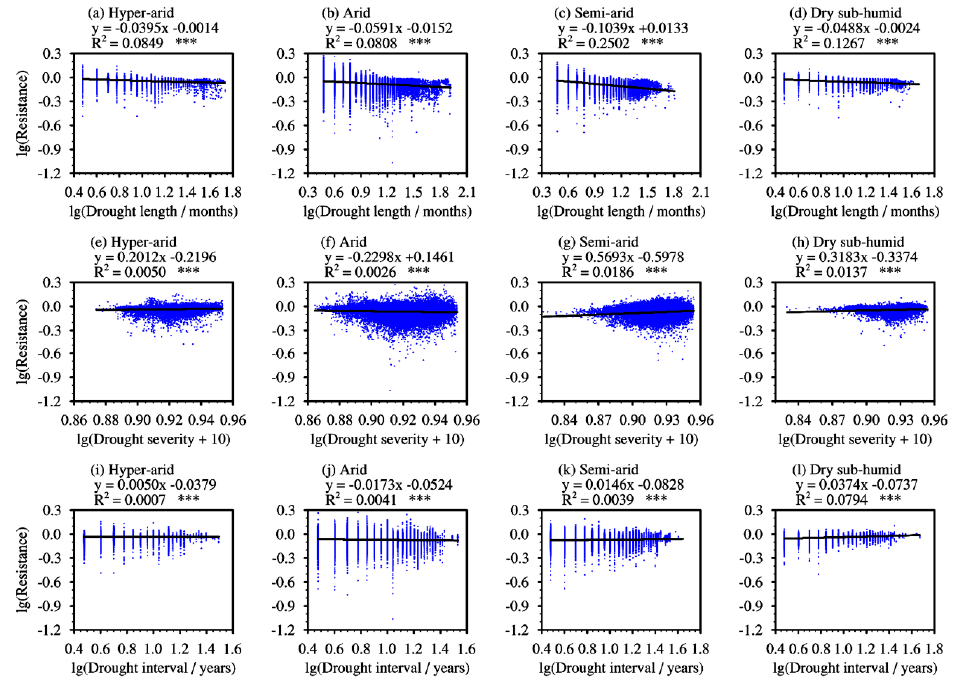
Figure 5. Changes in resistance as drought intensity in ( a – d ) drought length, ( e – h ) severity, and ( i – l ) interval increases in case of incomplete resistance (resistance < 1) in the ( a , e , i ) hyper-arid, ( b , f , j ) arid, ( c , g , k ) semi-arid, and ( d , h , l ) dry sub-humid regions. lg indicates the log 10 transformed. The linear relationships between lg-transformed resistance and lg-transformed drought characteristics indicate the power-law relationships between resistance and drought characteristics. *** p < 0.001.